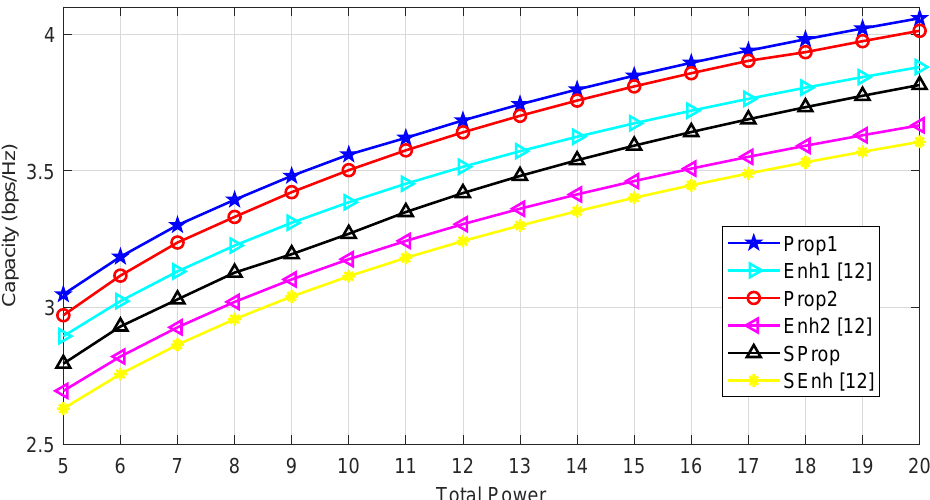
Figure 3. Capacity versus total transmit power of the base station (BS) for all